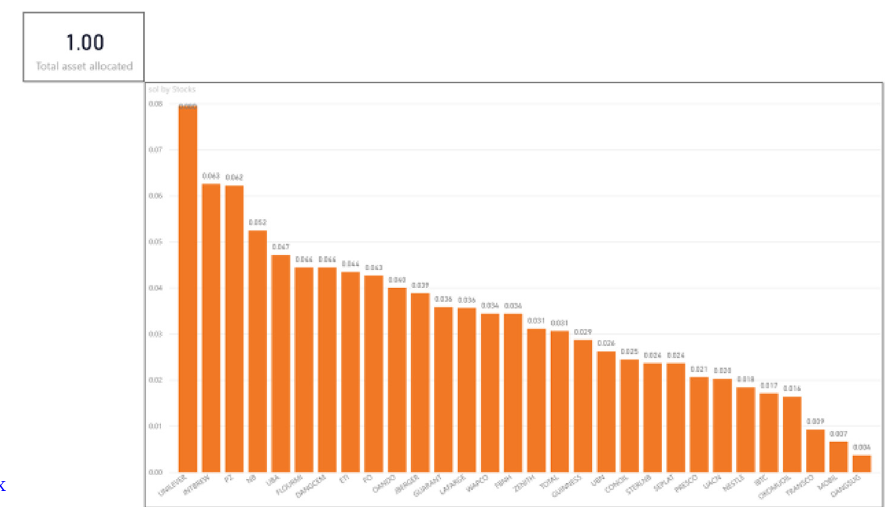
Table 2. Asset allocation distribution